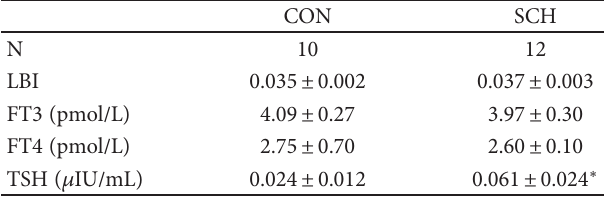
Table 1: Characteristics of subclinical hypothyroidism (SCH) and control mice (mean ± standard